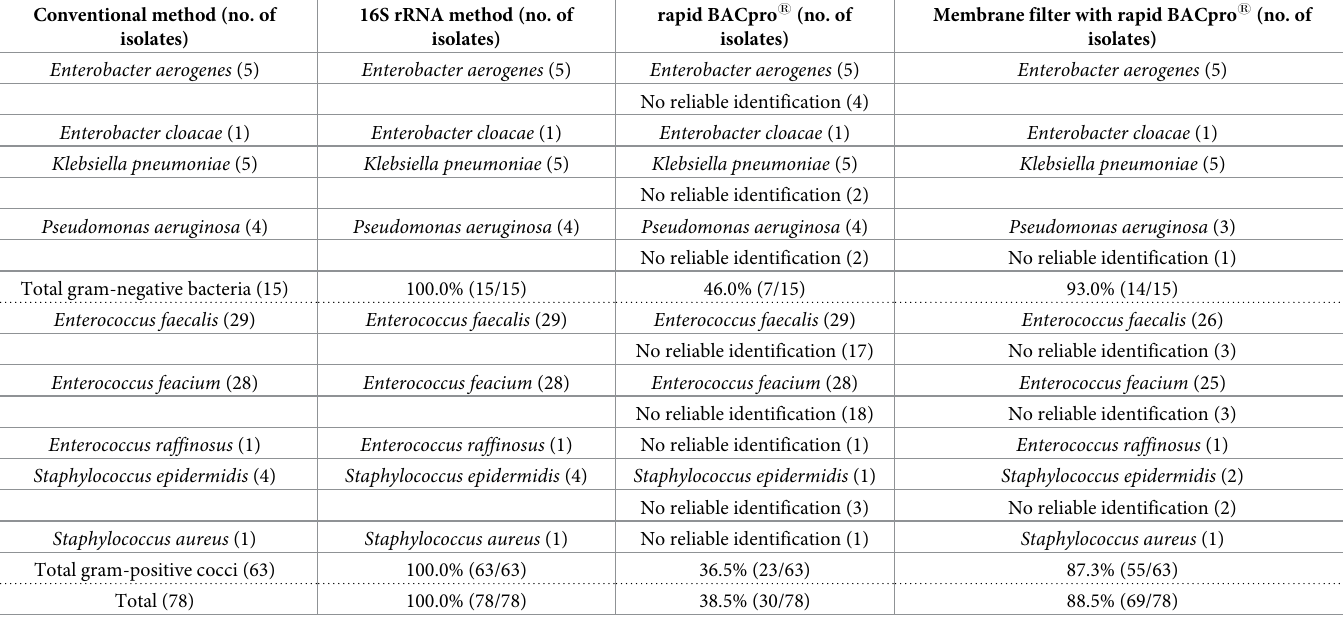
Table 4. Identification of 78 microorganisms by MALDI-TOF MS with different pretreatment methods. Membrane filter with rapid BACpro 1 (no. of Conventional method (no. of 16S rRNA method (no. of rapid BACpro 1 (no. of isolates) isolates) isolates)